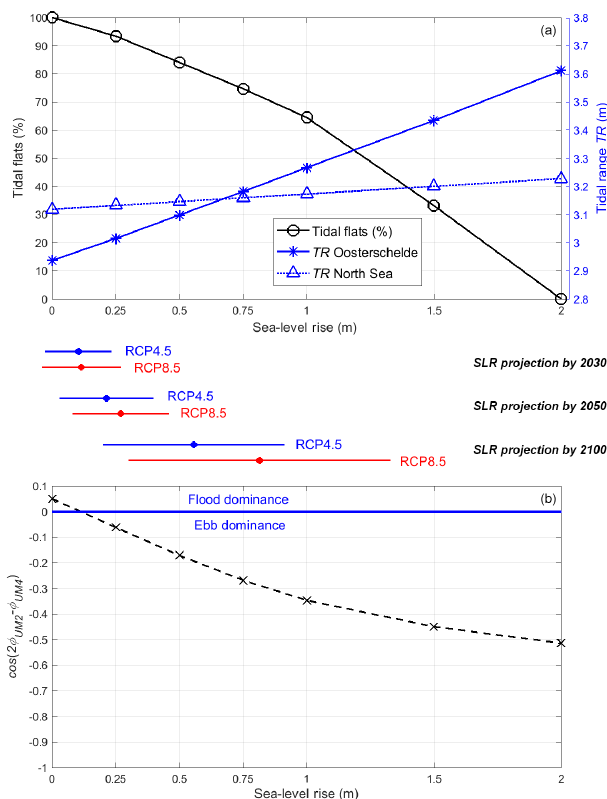
Figure 8. (a) Variations of the basin-average tidal flat percentage (defined as 100% in the baseline scenario) and average tidal range of the Oosterschelde and North Sea in the baseline and SLR scenar- ios; (b) , same as (a) , but for the cosine of M2–M4 velocity phase difference averaged over the Oosterschelde. The scales between the two panels are the local SLR projections (between the 5% and 95% confidence levels) in emission scenarios RCP4.5 and RCP8.5 in fu- ture decades, and the dots on each scale denote projection medians.